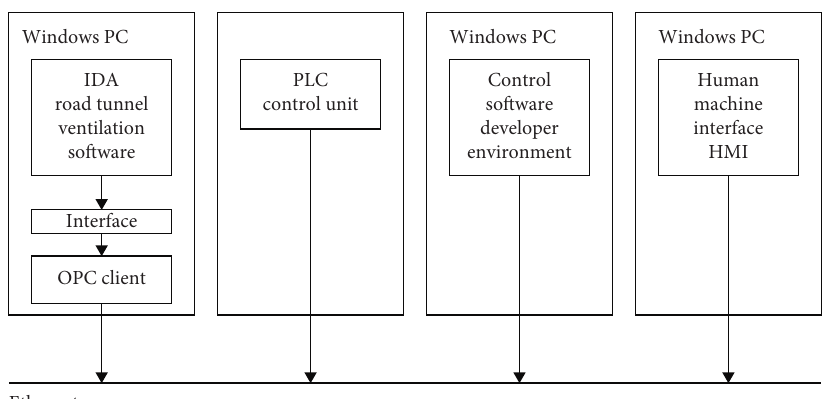
Figure 1: Architecture of the PLC-based Hardware-in-the-Loop (HIL) tunnel simulator [5].